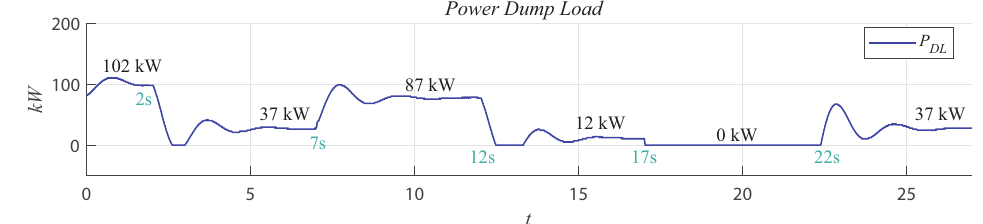
Figure 12. Power in the DL for case study